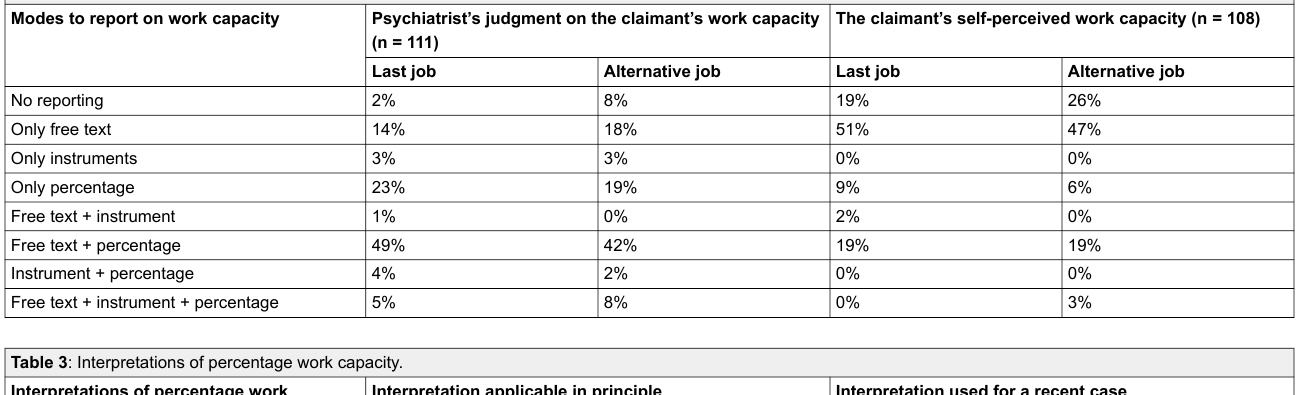
Table 2 : Current practice of reporting on work capacity through text, instrument(s), percentage or combinations.